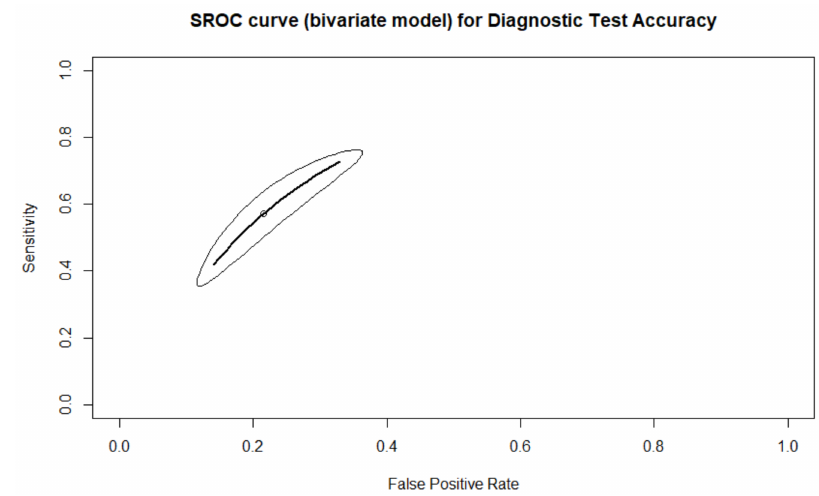
Figure 9. SROC of the prediction of ploidy status outcome.